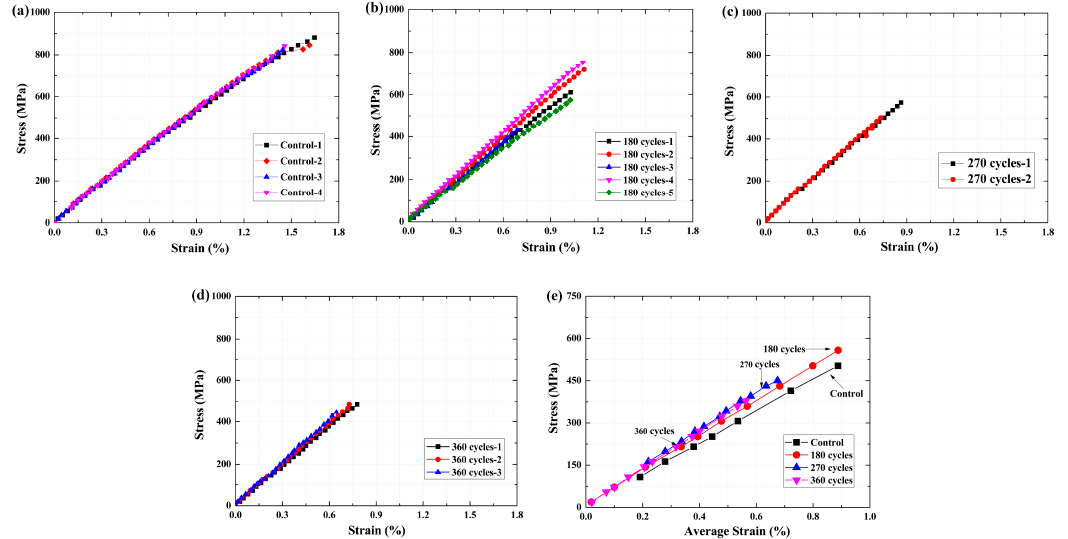
Figure 14. Mechanical properties of the BFRP sheets with increasing wet–dry cycles, ( a ) control; ( b ) 180 cycles; ( c ) 270 cycle cycles; ( d ) 360 cycle cycles; ( e ) average strain.